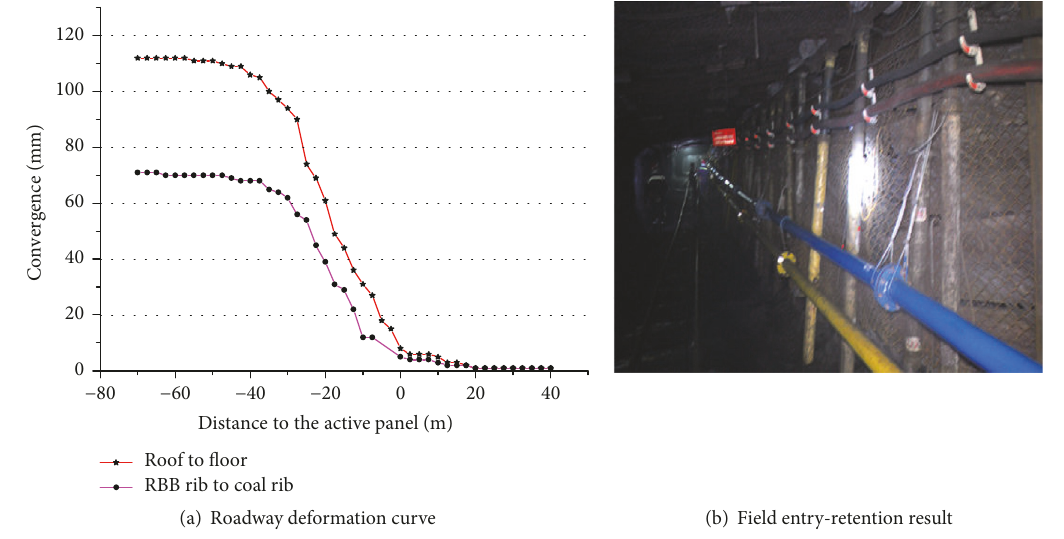
Figure 15: Result monitoring of GER with fully mechanized gangue backfilling